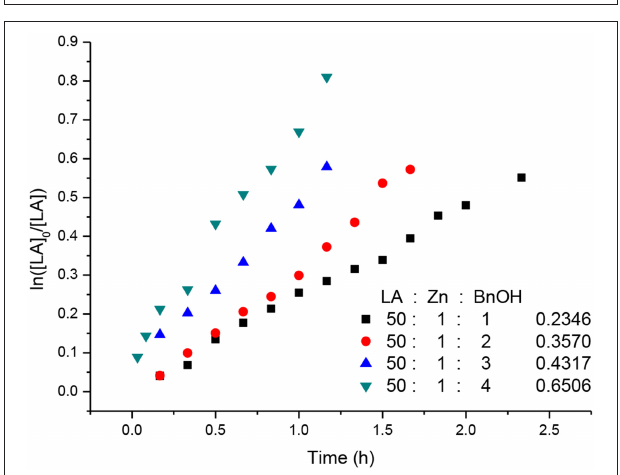
FIGURE 7 | First-order kinetic plots for L -LA polymerizations vs. time in toluene (10mL) at 25 ◦ C with various concentrations of [BnOH].